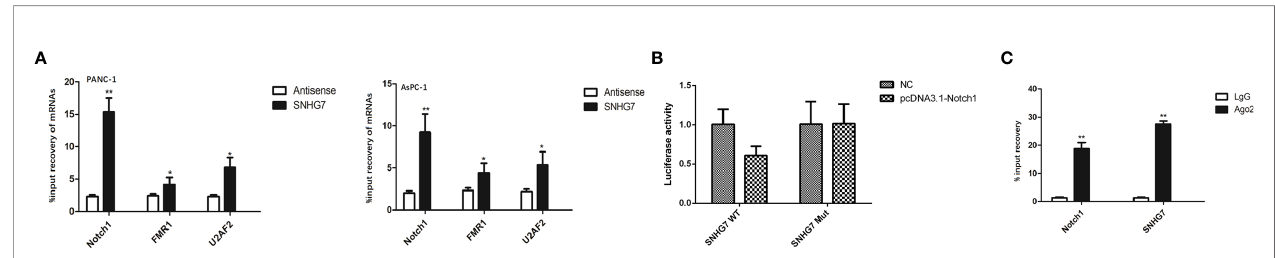
FIGURE 5 | SNHG7 interacted with Notch1 to regulate the stemness and Fol fi rinox resistance in pancreatic cancer. (A) RT-qPCR western blot analyses revealed that three of the most upregulated miRNAs in pancreatic cancer cells respond to co-culture with MSC. (B) Pull down assay depicted that only Notch1 could be pulled down by SNHG7. (C) RIP analysis demonstrated the co-immunoprecipitation of SNHG7 and Notch1. *P < 0.05, **P <